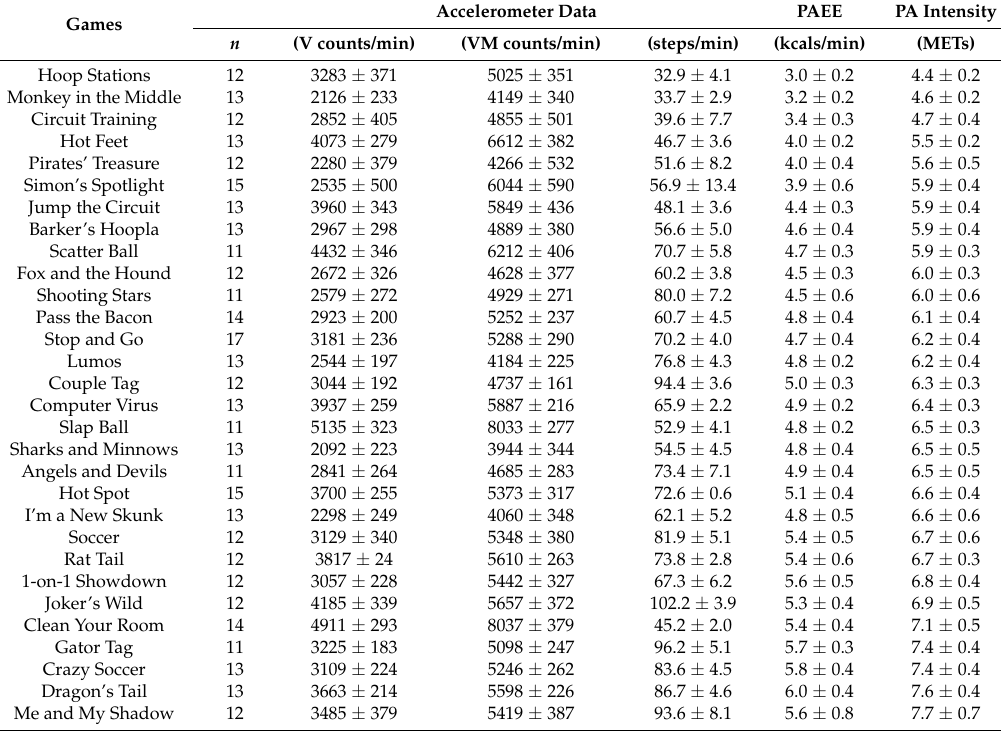
Table A1. PAEE, PA Intensity, and Counts and Cadence by Game (Means ±